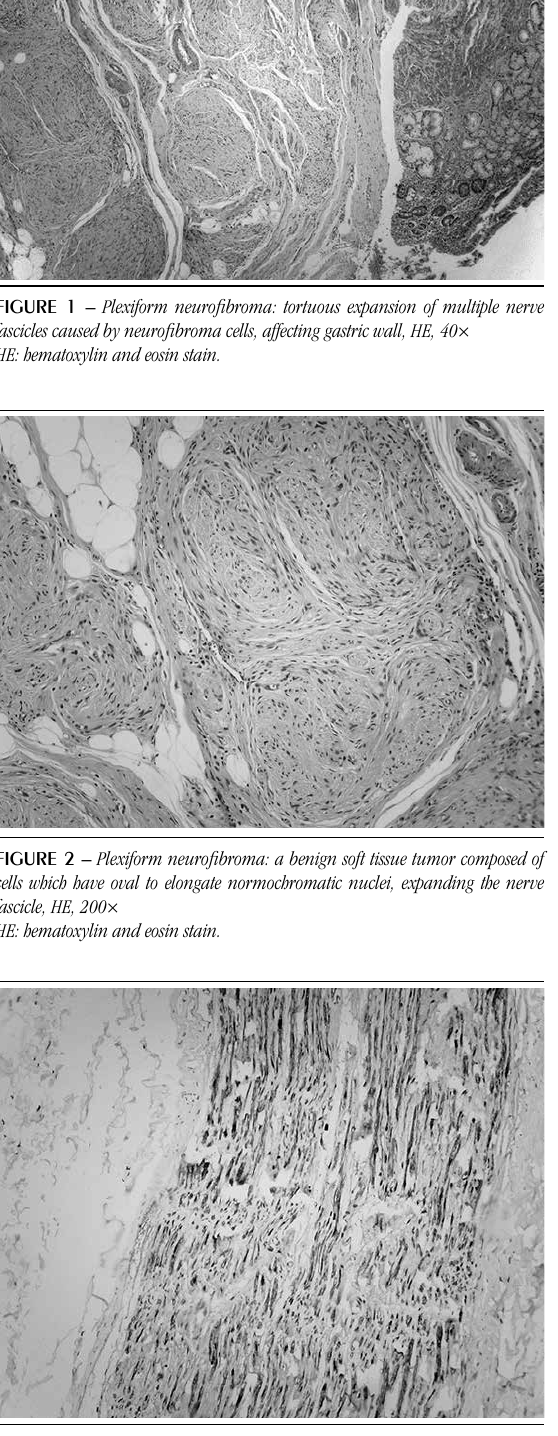
FIguRe 3 – Plexiform neurofibroma: positive immunoexpression for S100 antibody, streptavidin-biotin,